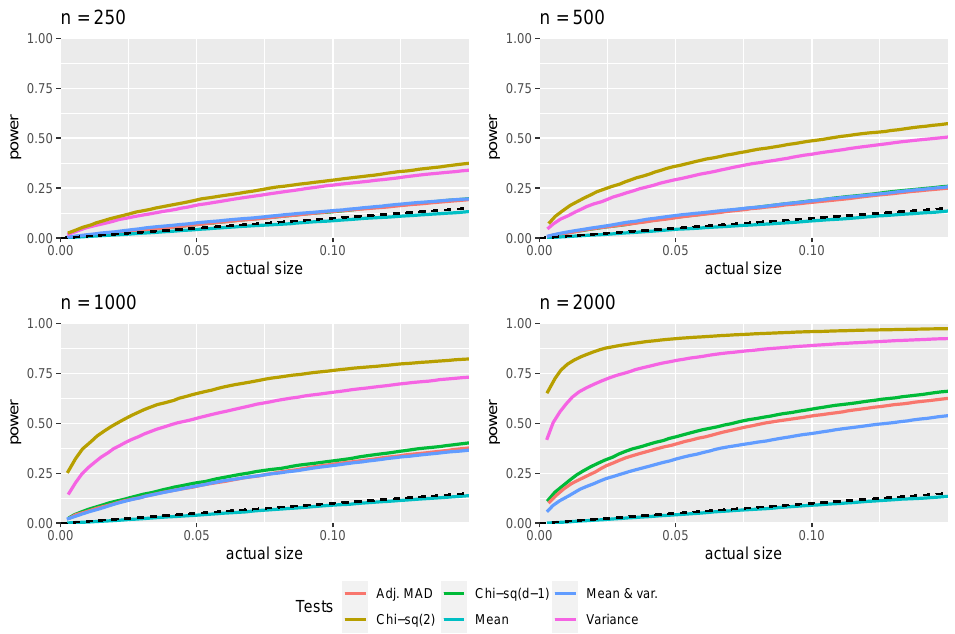
Figure 8. First two digits tests: size–power curves of the tests against the normal mixing alternative with λ = 0.9. Tests are as follows: “Adj. MAD”, adjusted MAD (10); “Chi-sq(2)”, χ 2 ( 2 ) test on mean and variance (4); “Chi-sq(d-1)”, χ 2 ( 89 ) test (9); “Mean”, normal test on the mean (1); “Mean & var.”, normal test on mean and variance (3); “Variance”, normal test on variance (2). The dashed line is power = actual size . The number of observations is indicated on top of each